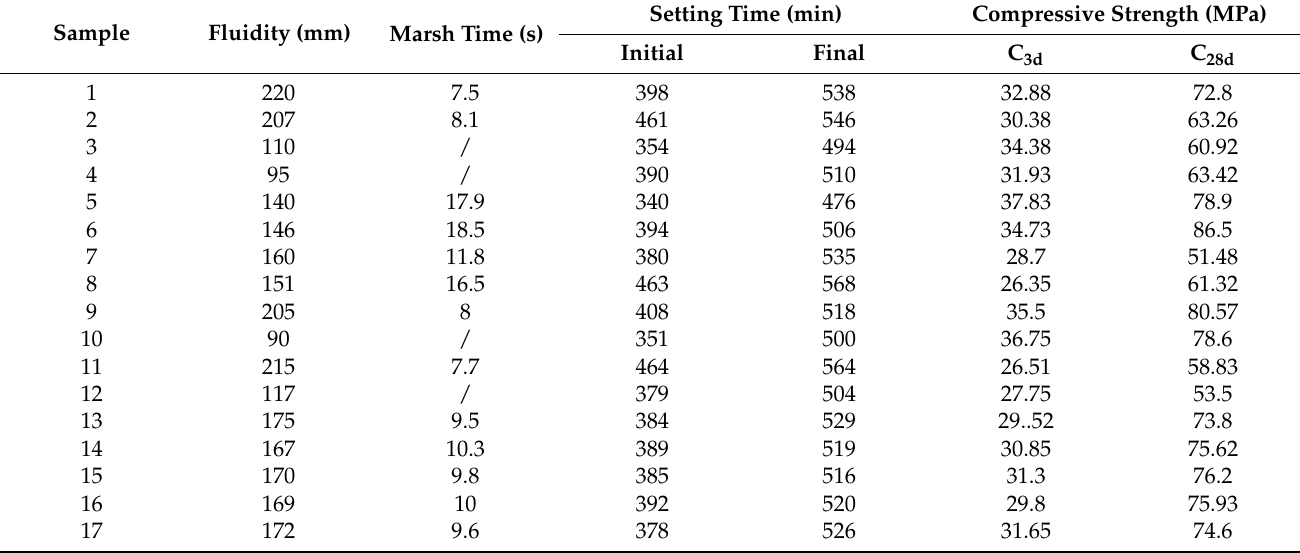
Table 4. Test results of macroscopic properties of samples.